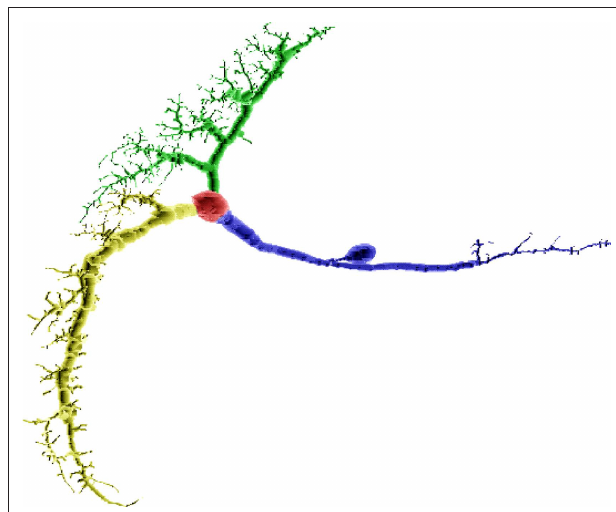
FIGURE 9 | A VS2 cell’s compartmental model from the blowfl y’s visual system (Borst and Haag, 1996) split such that the largest subtree is minimized. Red indicates location of the root compartment. This cell cannot be split in a manner such that its subtrees can be partitioned into two equally large sets.